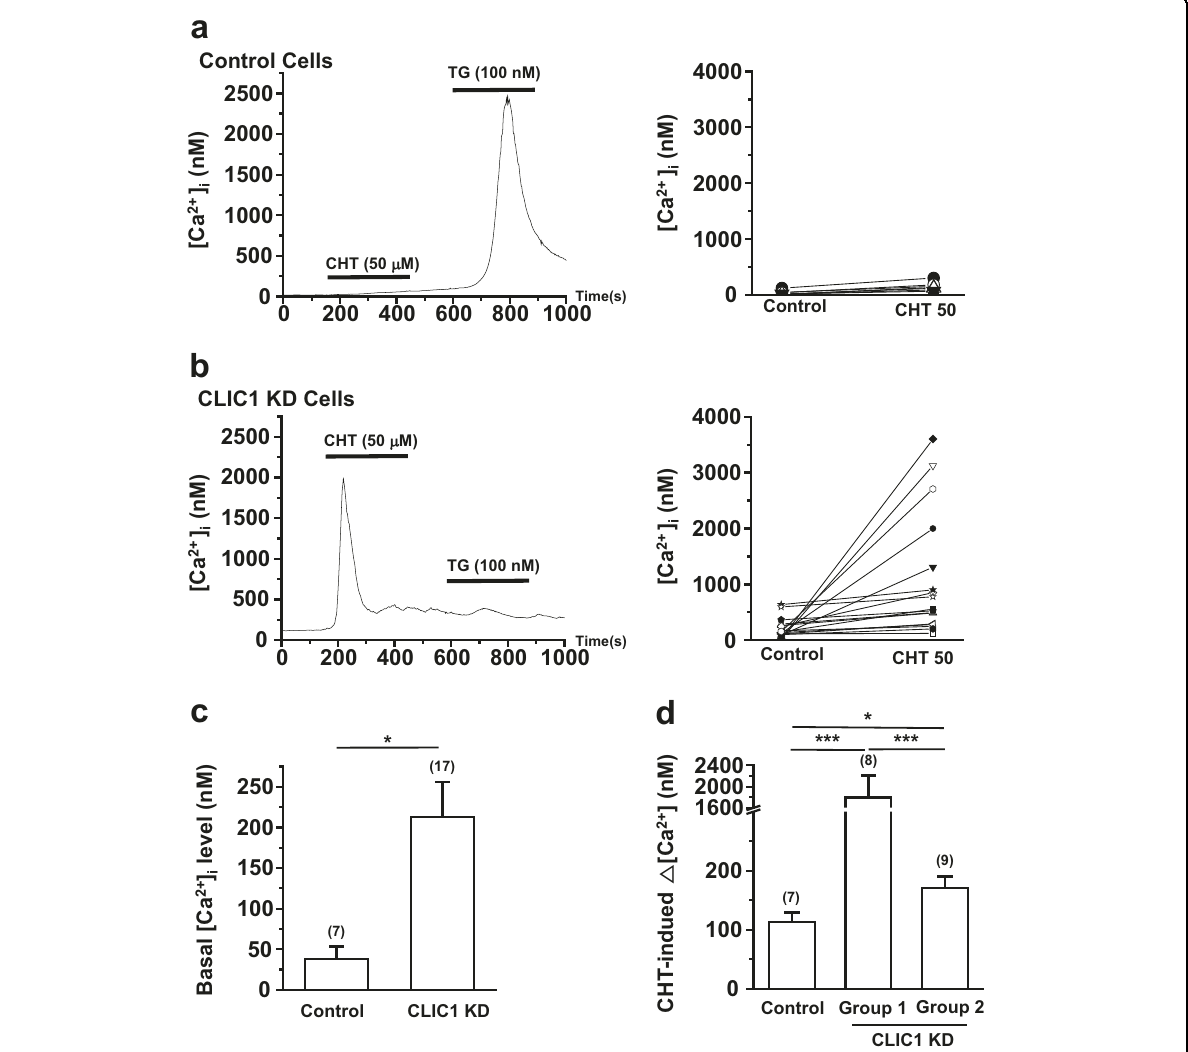
Fig. 3 CLIC1 knockdown increased the basal Ca2 + level and augmented the effects of chelerythrine on [Ca 2 + ] i . a, b Left, intracellular [Ca 2 + ] i recording upon exposure to chelerythrine chloride (CHT, 50 μ M) in control cells ( a ) and CLIC1 KD cells ( b ). Thapsigargin (TG, 100 nM) was used as the positive control. Right, individual data from control cells ( a ) and CLIC1 KD cells ( b ). c Quanti fi cation of the basal [Ca 2 + ] i in control and CLIC1 KD A549 cells. d Quanti fi cation of the chelerythrine-induced Δ [Ca 2 + ] i in control and CLIC1 KD A549 cells, named group 1 and group 2. * P < 0.05; ** P < 0.01; and *** P < 0.005 by Student ’ s t